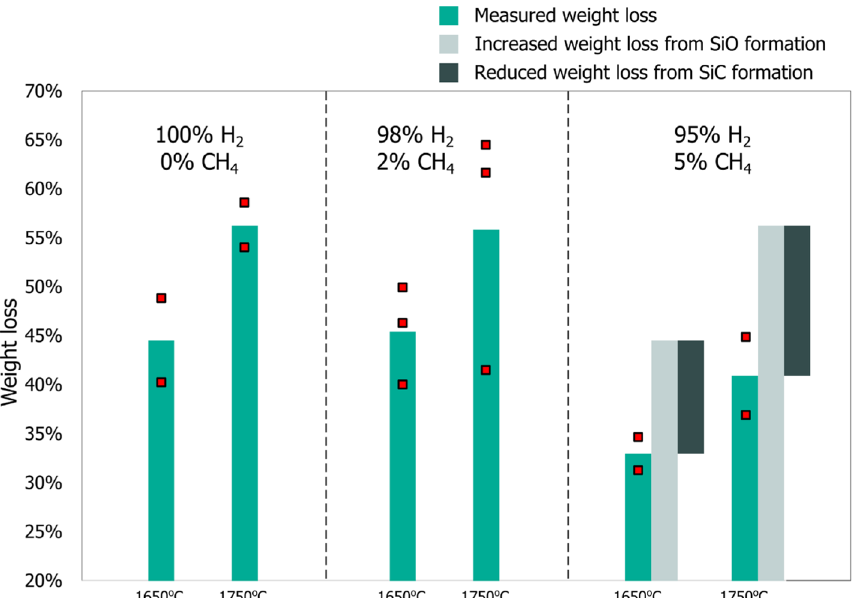
Figure 5. A comparison of weight loss relative to starting weight of the raw material at each temperature and process gas. The weight loss includes the crucible weight change and the raw material weight